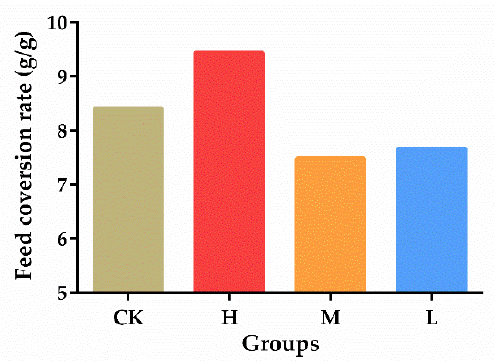
Figure 4. Effects of ALE on feed conversion rate in mice. Note: CK: 50 µ L 0.9% NaCl; H: 50 µ L 300